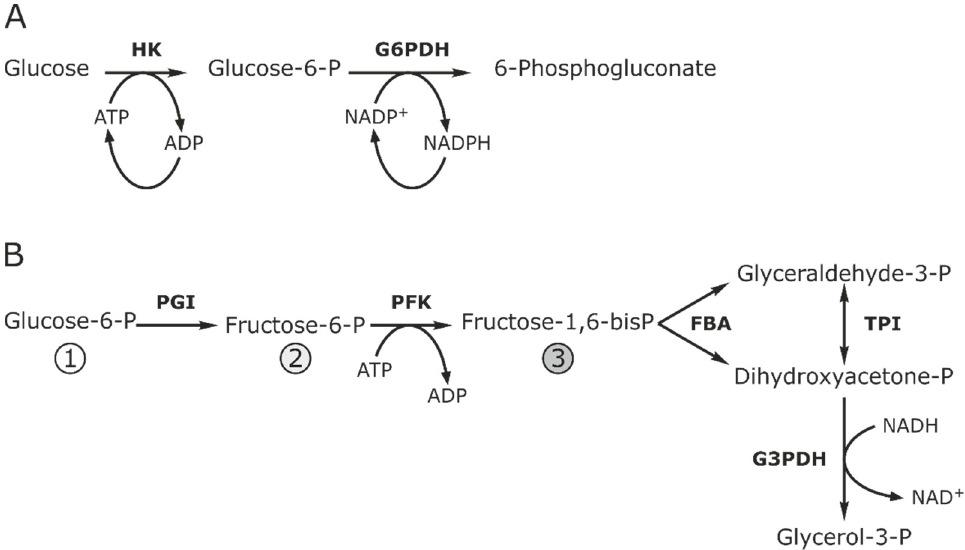
Figure 11. ( A ) Coupled HK / G6PDH assay to assess the HK activity. ( B ) Coupled NADH assay to assess the activities of PGI, PFK, and FBA. The individual reactions were started with substrates indicated by the numbers in circles. Table 2. Summary of the kinetic parameters of HK, PGI, PFK, and FBA. The experimentally assessed values were deduced from Lineweaver-Burk and Eadie-Hofstee plots. Reference values for K m and V max from Brenda and Sigma’s product data sheets are indicated, respectively. Lot No., lot number; sp. act., specific activity. Reference This Reference Lineweaver-Burk * Eadie-Hofstee Sigma Study Brenda